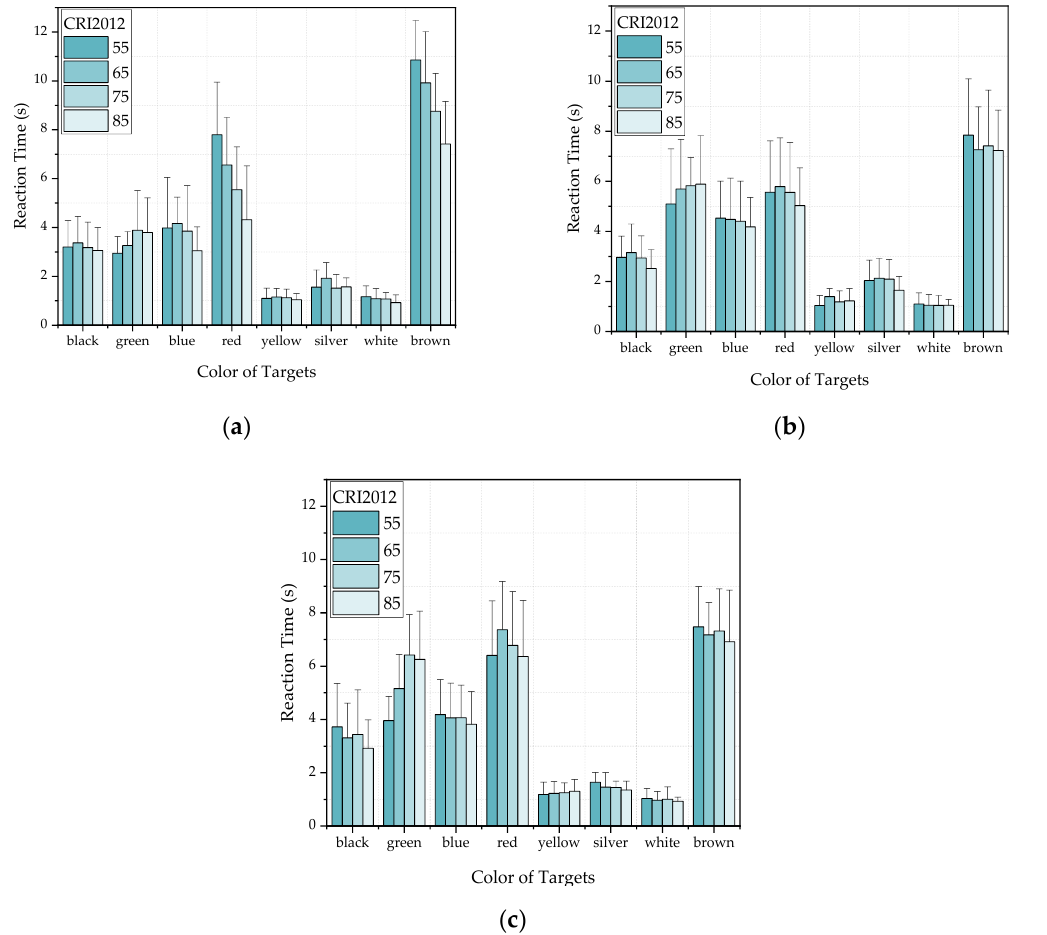
Figure 11. The mean reaction time of all subjects under different CRI2012s (a color difference-based color rendering index) and LP-CCTs (the CCTs simulated by LEDcube) when HP-CCT (the CCT of HP-LEDs) is 5700 K. (a) LP-CCT = 2800 K. (b) LP-CCT = 4500 K. (c) LP-CCT = 6400 K. Error bar shows the standard deviation. CRI2012 refers to a color difference-based color rendering index.